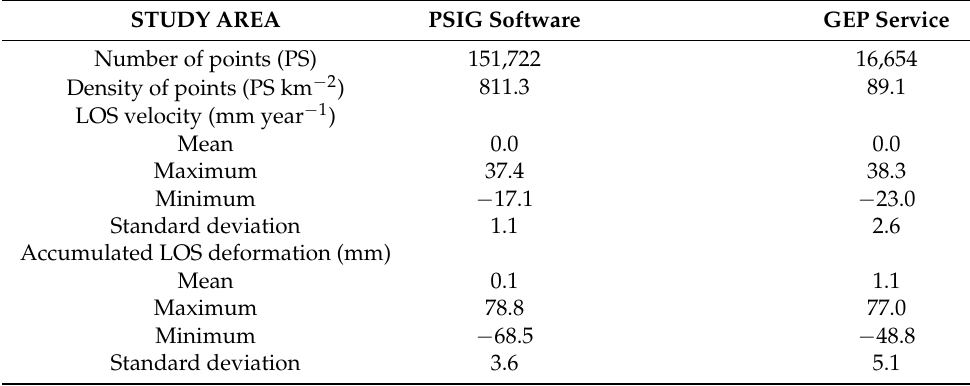
Table 2. Main characteristics of PSIG and GEP processing and A-DInSAR dataset: Statistics of LOS mean deformation velocity rates (mm year − 1 ) and accumulated LOS deformation